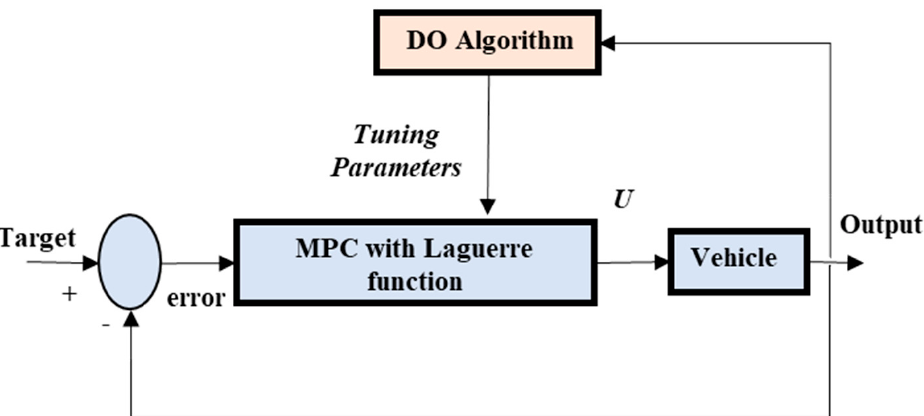
Figure 5. The online tuning representation of the developed DTLF-MPC based on DO.